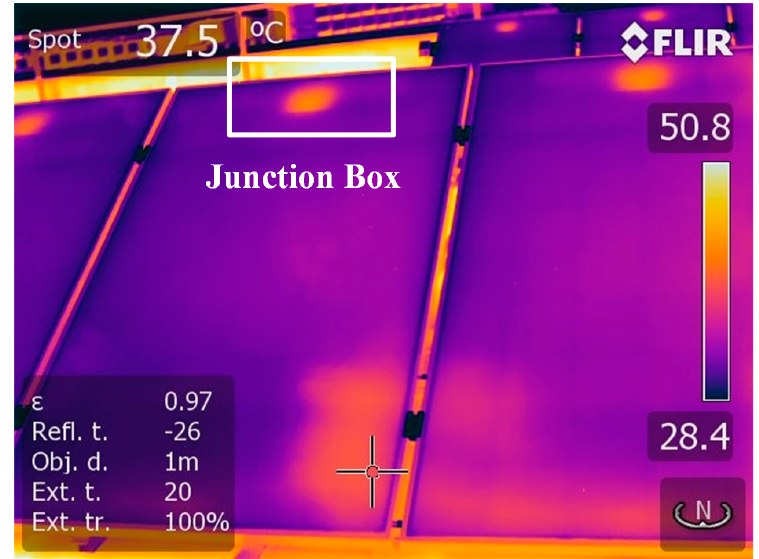
Figure 6. IR image of junction box.